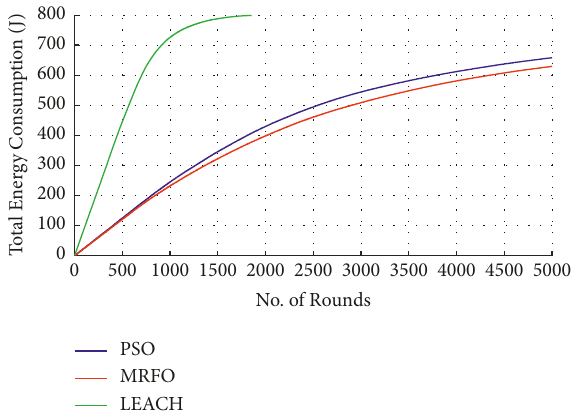
Figure 16: Total energy consumption for 500-node network, 50 CHs when the BS is at the corner of ROI.